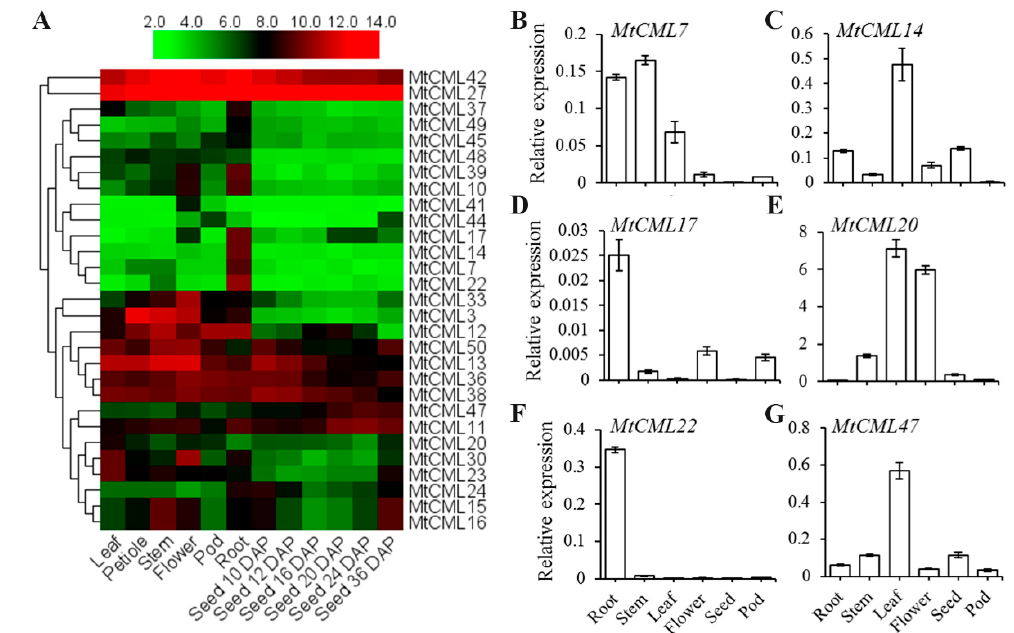
Figure 4. Expression analysis of MtCML genes in different organs. ( A ) Expression patterns of MtCML genes in leaves, petioles, stems, flowers, pods, roots and seeds. The expression levels of MtCML genes are shown as the log2-based fluorescence intensity values from the microarray data (MtGEA, https://mtgea.noble.org/v3/). DAP, days after pollination; ( B – G ) relative expression of ( B ) MtCML7 ; ( C ) MtCML14; ( D ) MtCML17; ( E ) MtCML20; ( F ) MtCML22; ( G ) MtCML47 in roots, stems, leaves,